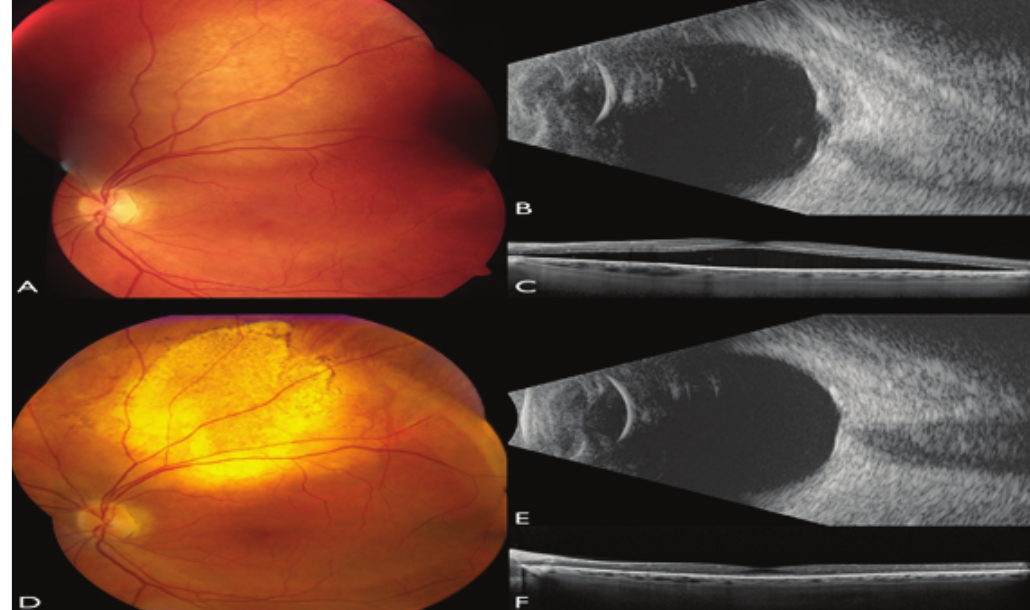
Figure 6. Choroidal metastasis managed with PDT. Fundus photograph of the left eye of a patient with choroidal metastasis located superior to the macula (A) and confirmed by B-scan ultrasonography (B). The tumor was associated with subfoveal fluid as seen on OCT (C). Following the PDT application, there was a complete tumor regression (D) confirmed by B-scan ultrasonography (E) and resolution of the subfoveal fluid as seen on OCT